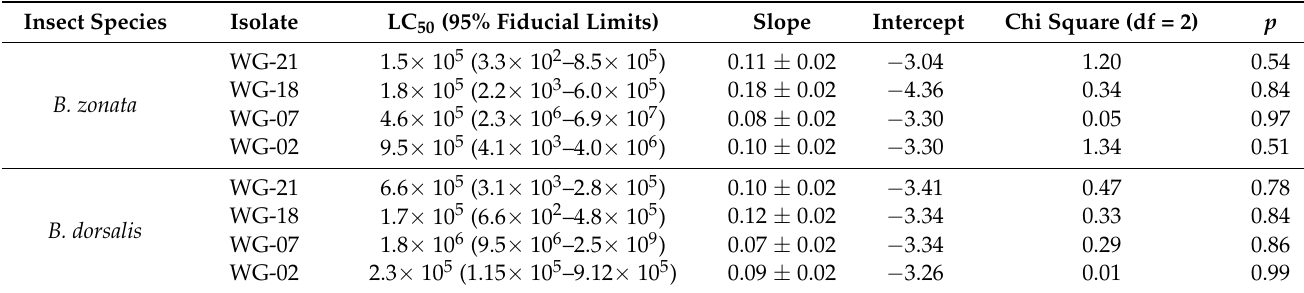
Table 6. Probit analysis of estimate lethal concentrations (conidia mL − 1 ) required to kill 50% (LC 50 ) of adults of B. zonata and B. dorsalis along with their 95% fiducial limits. p value represents the goodness of fit test. Insect